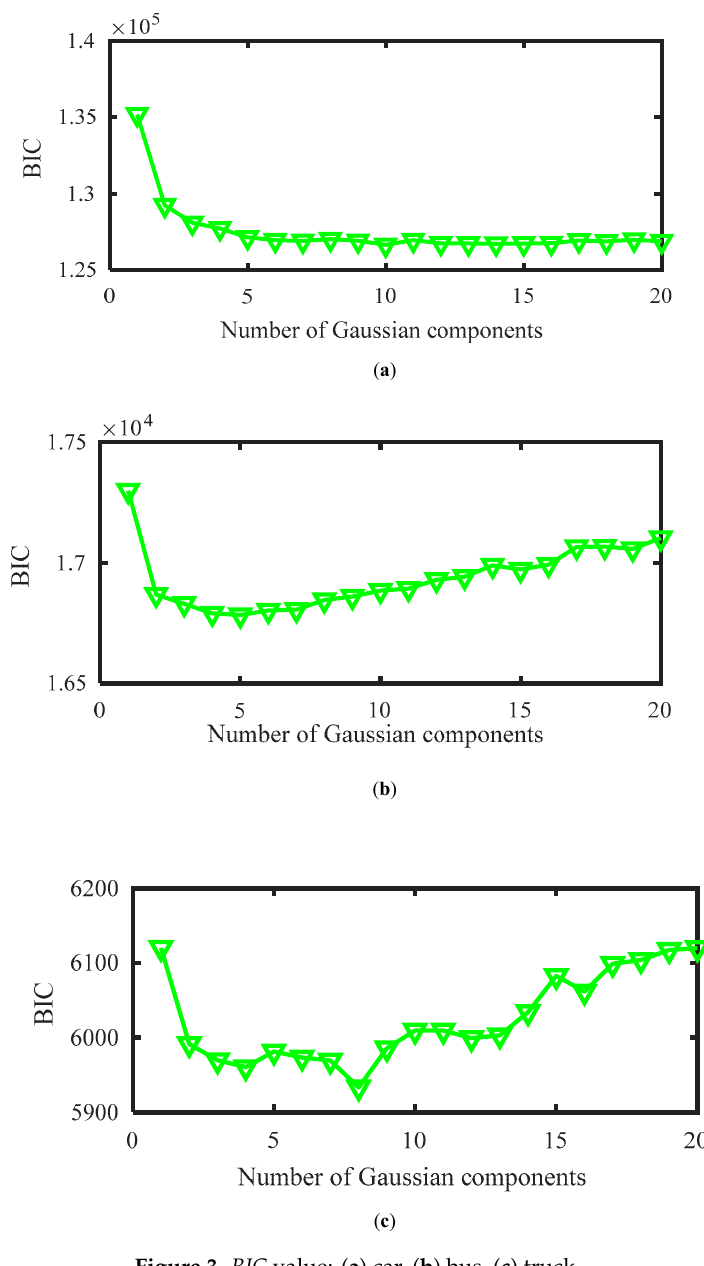
Figure 3. BIC value: ( a ) car, ( b ) bus, ( c ) truck.